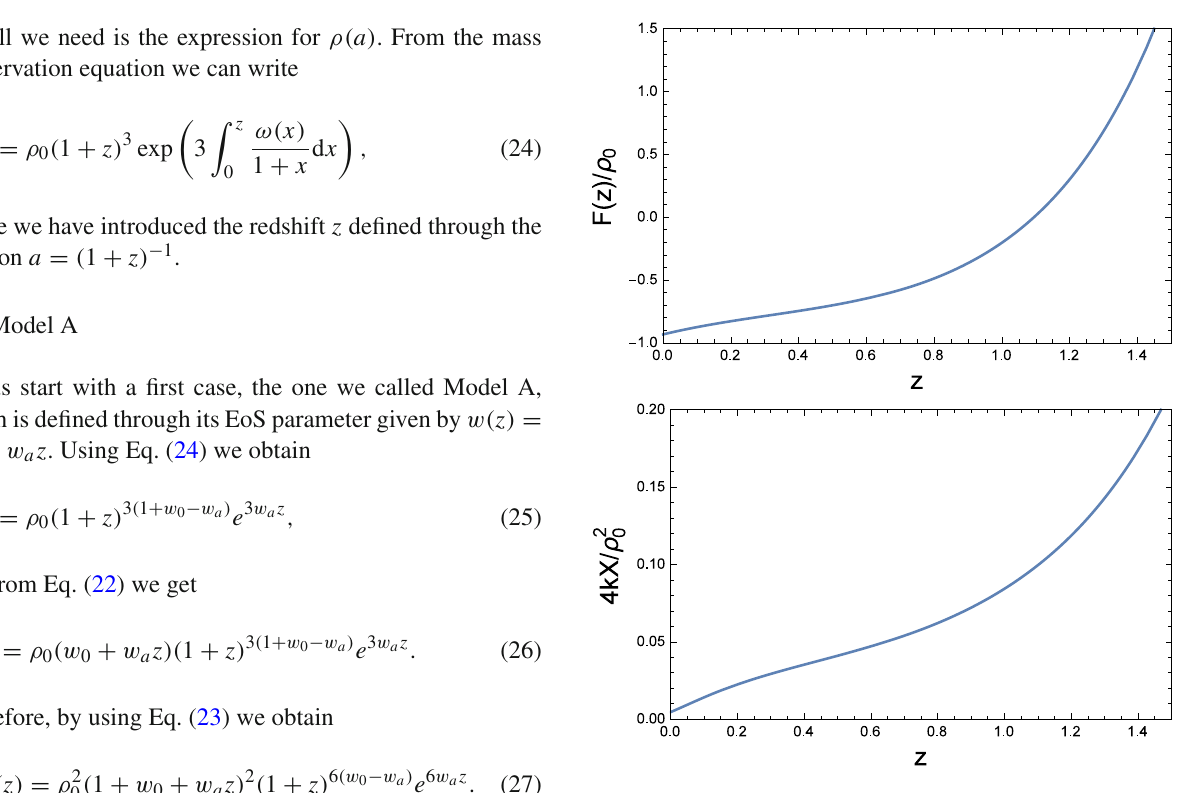
Fig. 1 Here we display F and X as a function of redshift based on Eqs. (26) and (27) for model A characterized by the parametrization